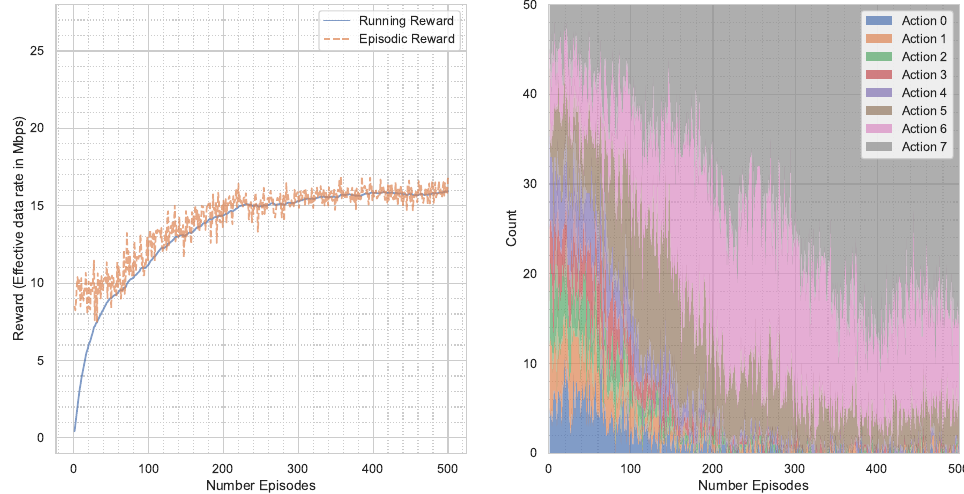
Figure 5. The behavior of the NAC reinforcement learning approach on an AWGN channel with a sweeping SNR level between 0dB and 50dB.